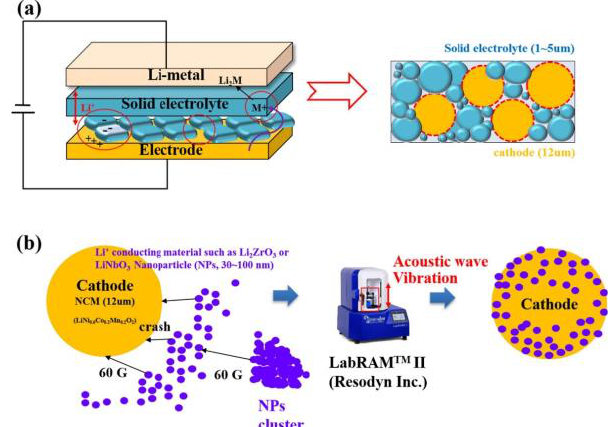
Figure 15. Schematic diagrams of ( a ) critical drawbacks of all-solid-state Li batteries and ( b ) resonant acoustic dry coating technique. Reproduced with permission from [265]. Copyright 2020